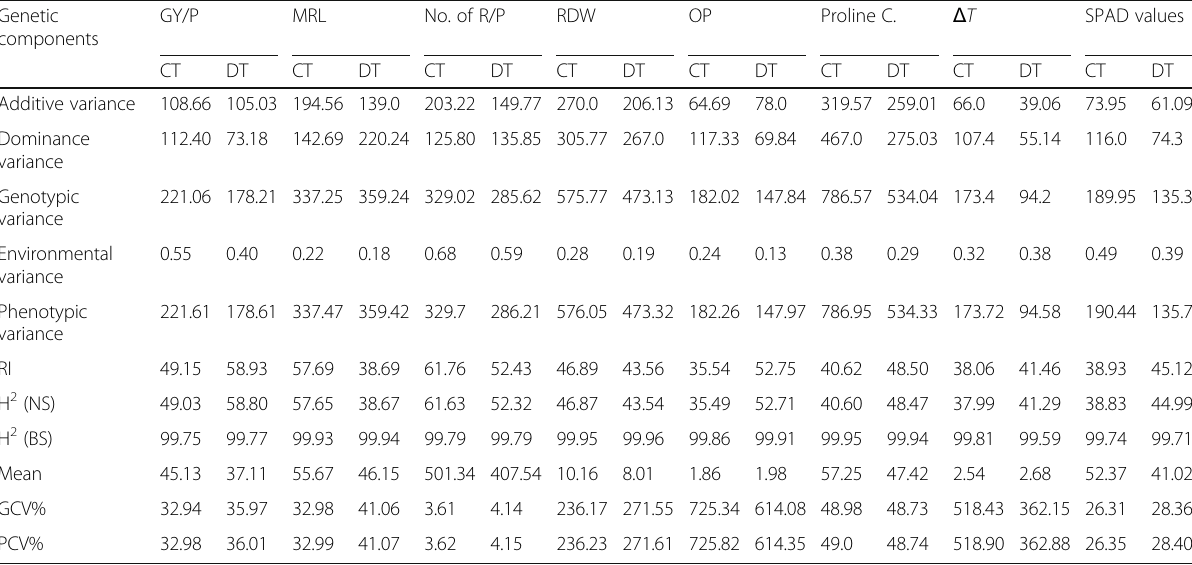
Table 8 Determination of all genetic parameters in all traits estimated under the control treatment and water deficit conditions Genetic components